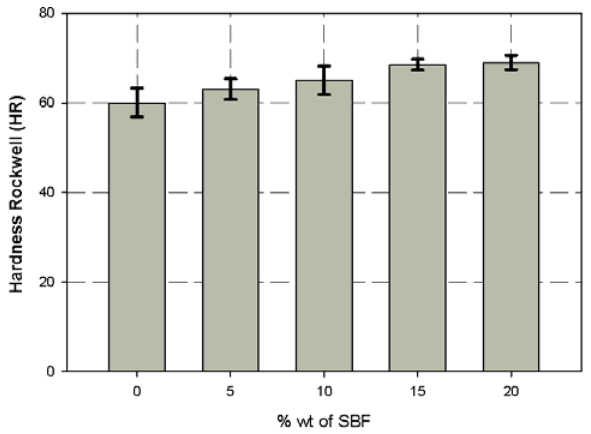
Figure 8. Vickers hardness variation with wt % of ABS.